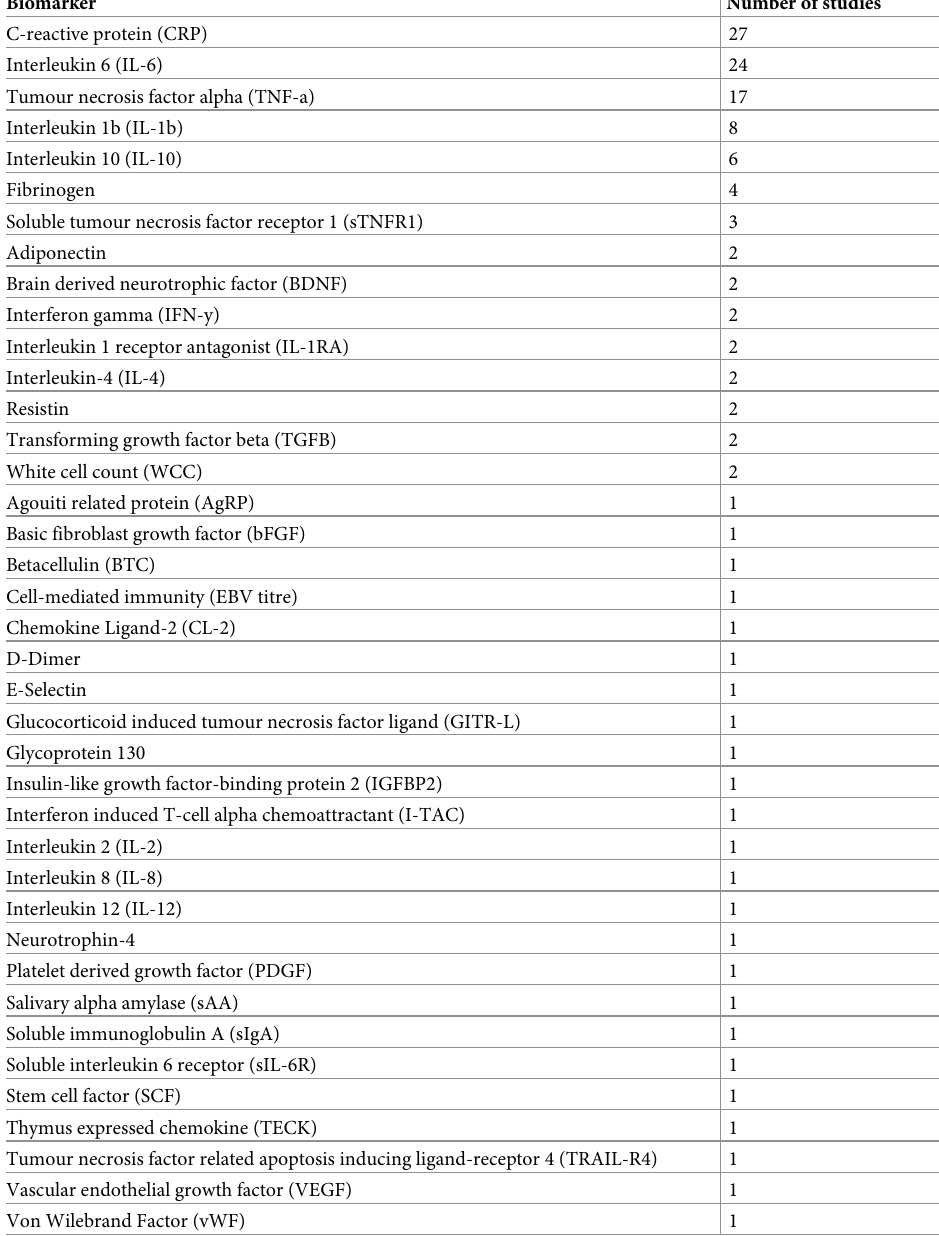
Table 1. Frequency with which biomarkers are reported in included